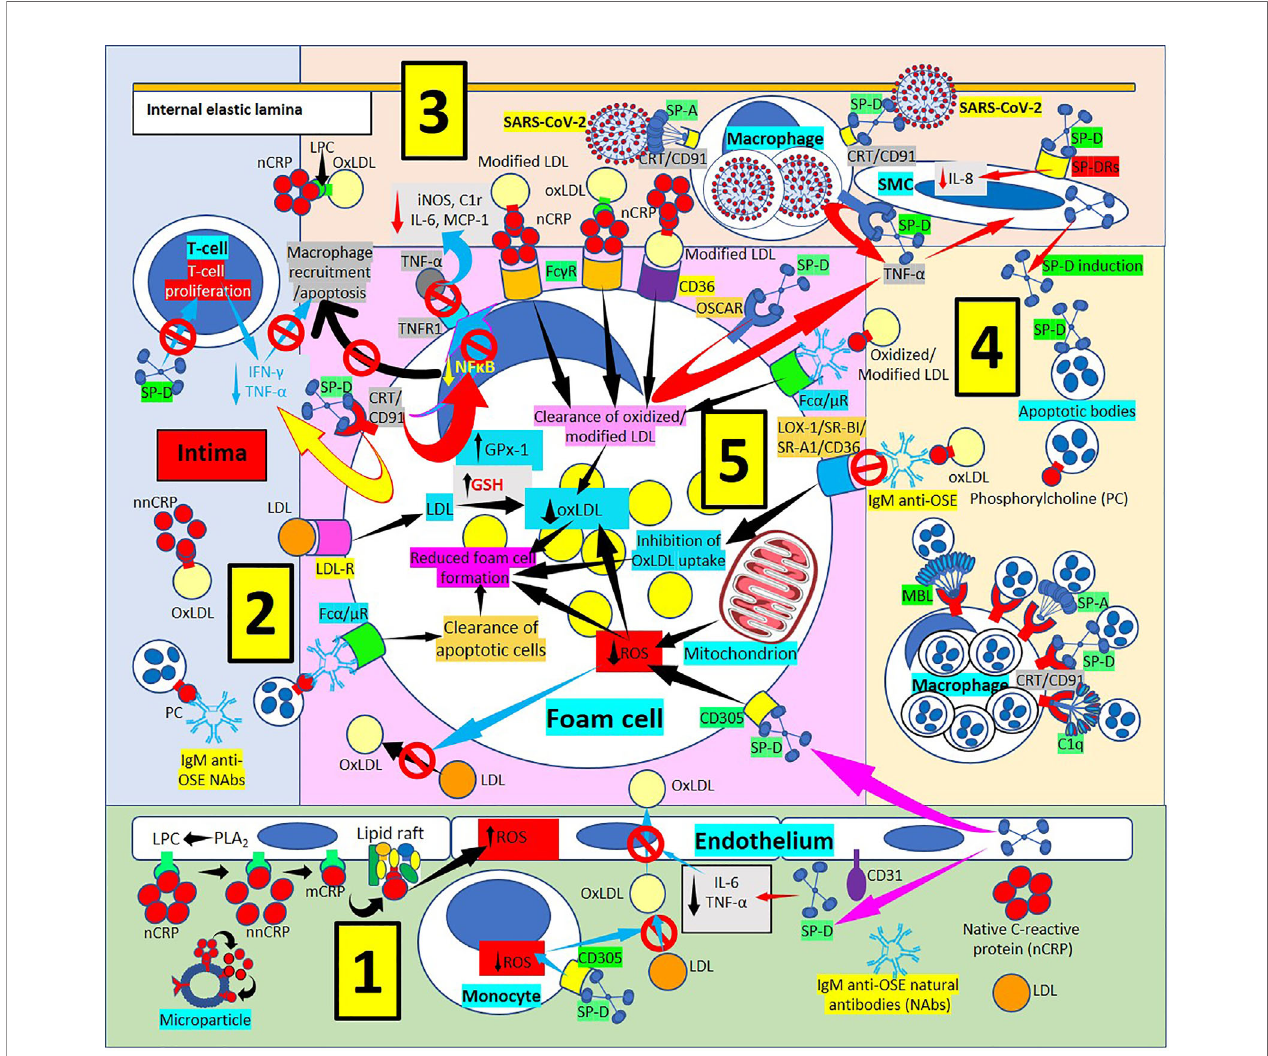
FIGURE 4 | Surfactant protein innate immunoprotective responses in atherosclerotic lesions. [1] SP-D can be synthesized by endothelial cells and released into plasma and arterial intima, and circulatory SP-D inhibits circulatory IL-6 and tumor necrosis factor- a (TNF- a ) and the transport of oxidized low-density lipoprotein (OxLDL) from the artery lumen to the subendothelial space; SP-D bound to CD305 (leukocyte-associated immunoglobulin-like receptor 1, LAIR1) reduces generation of reactive oxygen species (ROS) in foam cells (right and center in 1, and lower right in 5). SP-D bound to CD305 reduces ROS generation in circulating monocytes, and reduced ROS impedes oxidation of LDL (center in 1). Circulating native C-reactive protein (nCRP) bound to cellular or microparticle lysophosphatidylcholine (LPC) generated by phospholipase A 2 (PLA 2 ), or to phosphorylcholine (PC) can be dissociated to monomeric CRP (mCRP) with intermediate formation of non-native CRP (nnCRP), and mCRP can bind lipid rafts and increase ROS formation (left in 1). [2] SP-D reduces T-cell proliferation and interferon- g (IFN- g ) and TNF- a release (top in 2). [3] [SP-D and SP-A facilitate intimal severe acute respiratory syndrome coronavirus-2 (SARS-CoV-2) virus removal by macrophages through CRT/CD91Rs (center in 3). SP-D binding to osteoclast-associated immunoglobulin-like receptor (OSCAR) in macrophages and foam cells enhances TNF- a release that stimulates SP-D production by smooth muscle (SMC) cells. SP-D also lowers SMC IL-8 (right in 3). [4] Pattern recognition proteins surfactant protein (SP)-A, SP-D, mannose binding lectin (MBL) and complement component 1q (C1q) facilitate macrophage uptake of apoptotic cells in atherosclerotic plaques through calreticulin (CRT)/CD91 receptors (Rs) (bottom in 4). [5] Immunoglobulin M (IgM) anti-oxidation-speci fi c natural antibodies (OSE NAbs) in the arterial intima facilitate macrophage/foam cell uptake of apoptotic cells through Fc a / m Rs (lower left in 5). Low-density lipoproteins (LDL) are taken by macrophages/foam cells through LDLRs (center in 5). Reduced foam cell ROS disallows LDL oxidation in the intima (lower left in 5). SP-D binding of CRT/CD91Rs leads to reduced in fl ammation characterized by reduced secretion of TNF- a in macrophages/foam cells; reduced nuclear factor k B (NF k B) activation and reduced macrophage recruitment and apoptosis; reduced expression of TNF- a receptor 1 (TNFR1) with concomitant reduction of foam cell TNF- a binding and reduced inducible nitric oxide synthase (iNOS), complement C1r protein, IL-6 and monocyte chemoattractant protein-1 (MCP-1) (upper left in 5). Native CRP (nCRP) facilitates clearance of oxidized/modi fi ed LDL through Fc g Rs and CD36 (upper right in 5); and IgM anti-OSE helps with clearance of oxidized/modi fi ed LDL through Fc a / m Rs (upper right in 5), and by inhibiting their uptake through scavenger receptors lectin-like oxidized low-density lipoprotein (LDL) receptor-1 (LOX-1), scavenger receptor class B type 1 (SR-BI), scavenger receptor A1 (SR-A1) and CD36 (right in 5); all leading to reduced foam cell